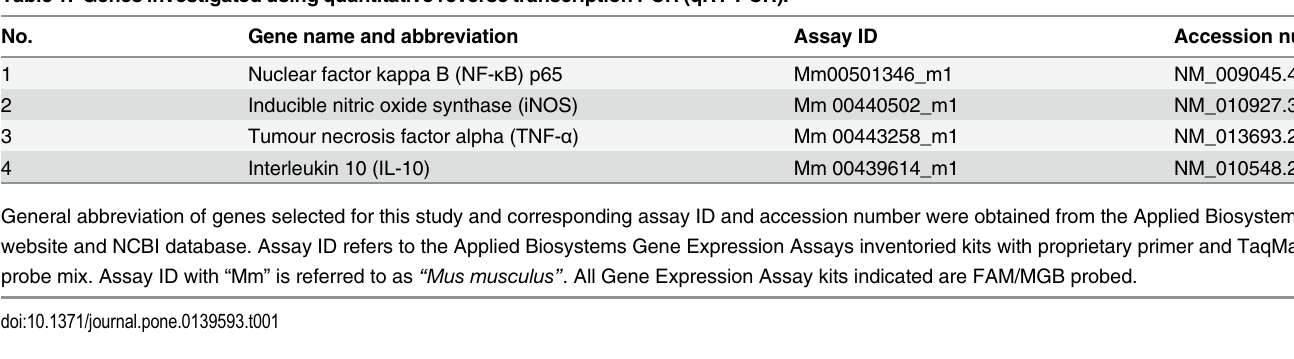
Table 1. Genes investigated using quantitative reverse transcription PCR